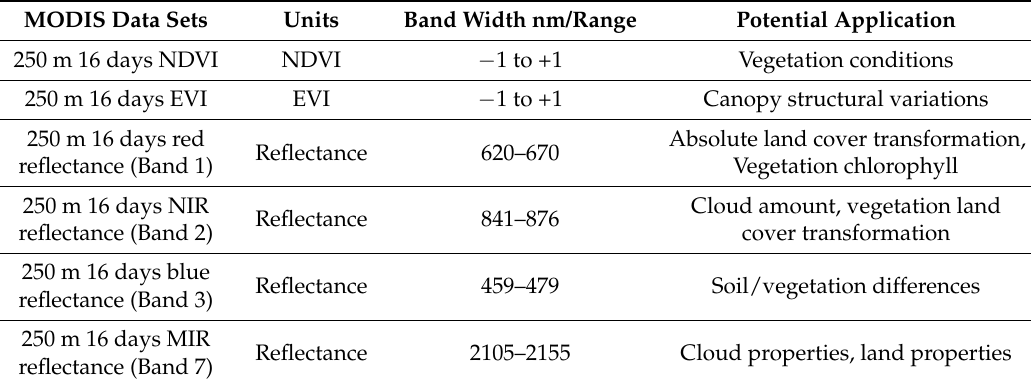
Table 1. MODIS—250 m Terra vegetation indices 16-day L5 product used in this